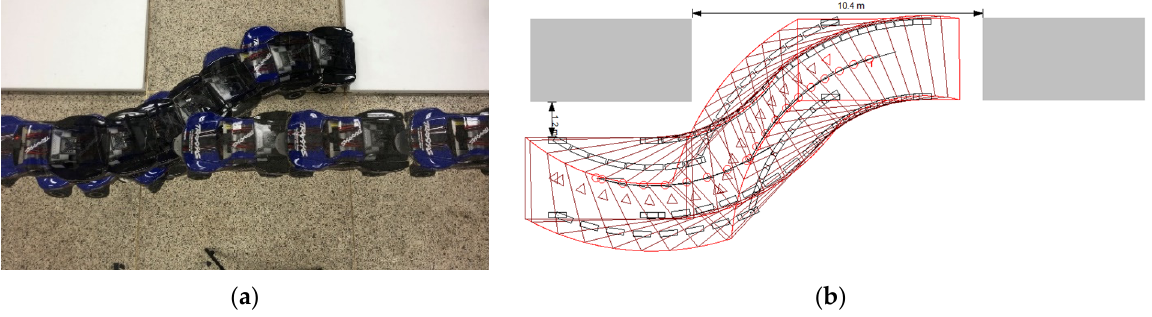
Figure 14. Success of three-characters ( S + R − L − ) parallel full parking ( ρ = 1): ( a ) Experimental parking test; ( b ) simulated parking